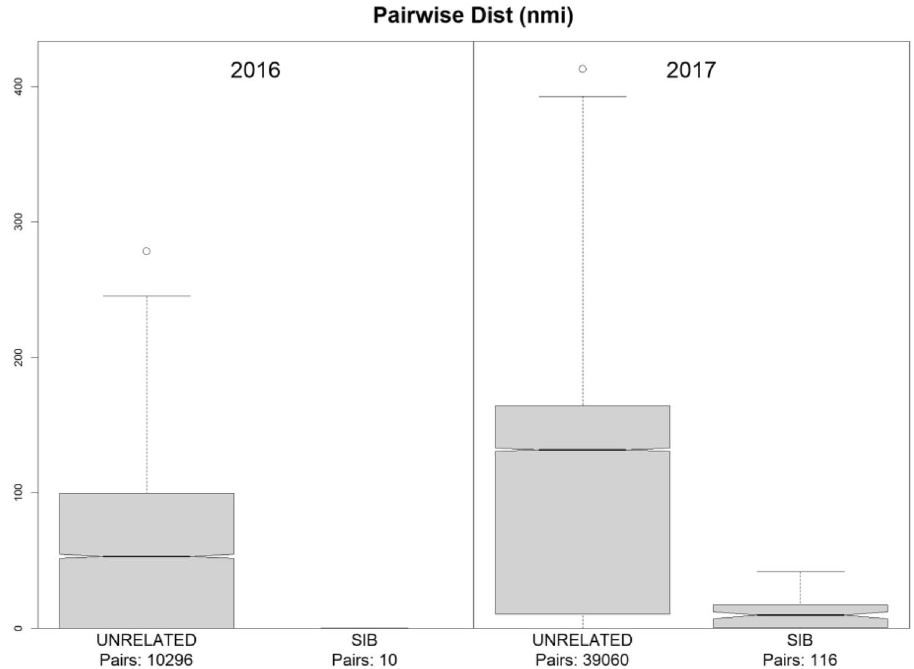
Figure 3. Intra-pair distances for sibling-pairs compared to unrelated pairs. Distances are based on tow locations; all 2016 sibling-pairs were within-tow, and therefore shown at zero